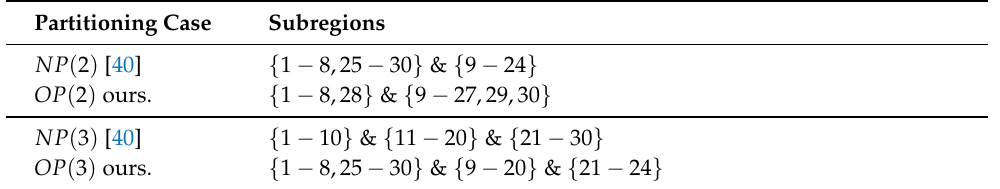
Table 2. Area partitioning cases for the IEEE 30-bus system.